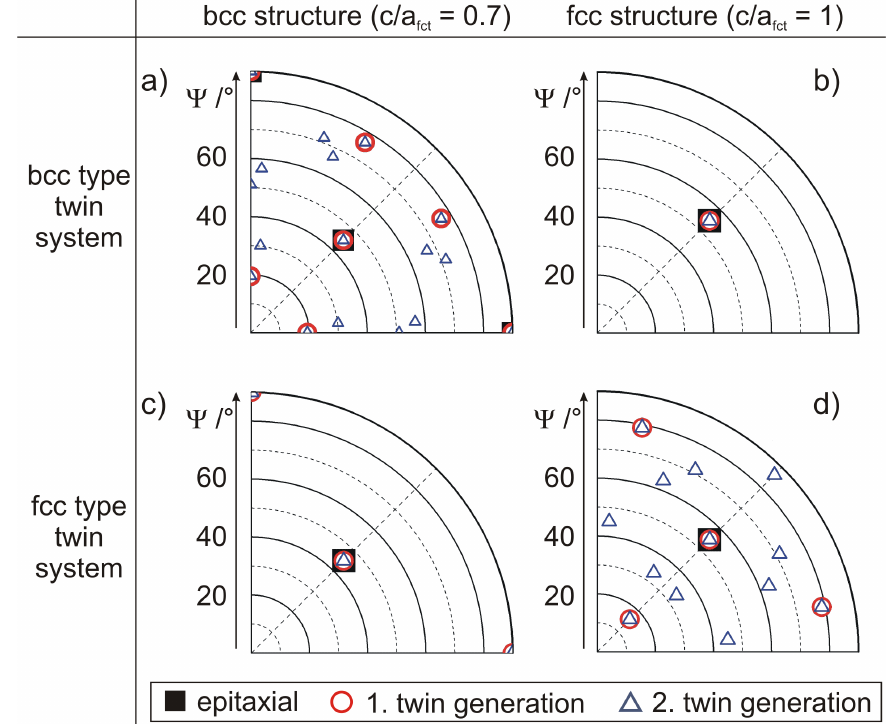
(cid:104) 111 (cid:105) ( a , b ) and bct bct